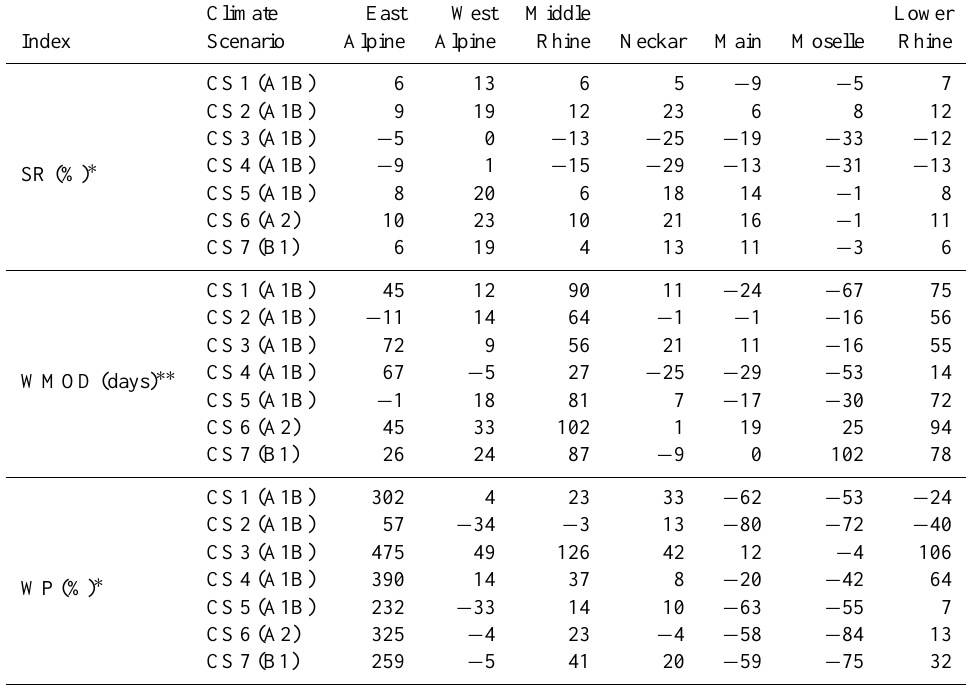
Table 4. Differences between the three seasonality indices estimated from simulated low flows using observed inputs for the reference period 1964–2007 (case 2) compared to the simulated low flows using simulated inputs from seven climate scenarios (CSs) for the same period (case